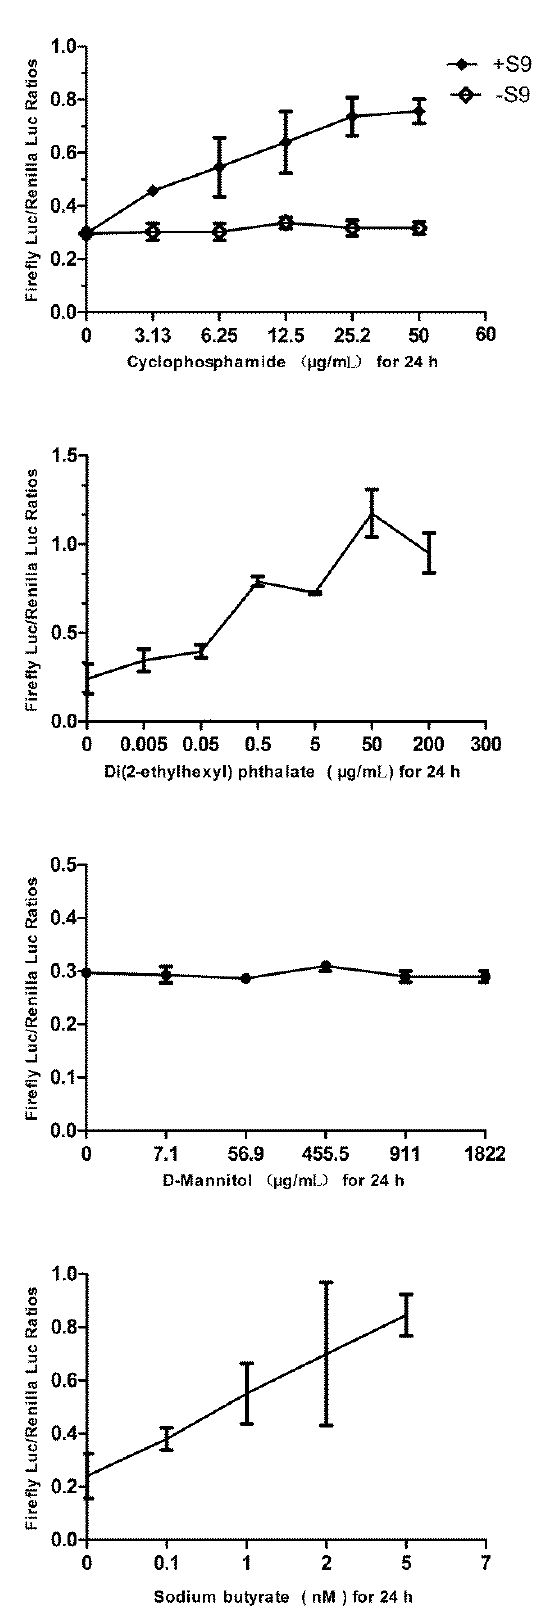
Figure 7. The responses of the p21FGLuc cells to varied concentrations of cyclophosphamide, di(2-ethylhexyl) phthalate (DEHP), D-mannitol and sodium butyrate for 24 h. S9+ and S9− refer to results with and without metabolic activation by the S9 mixture, respectively. Data are expressed as mean ±